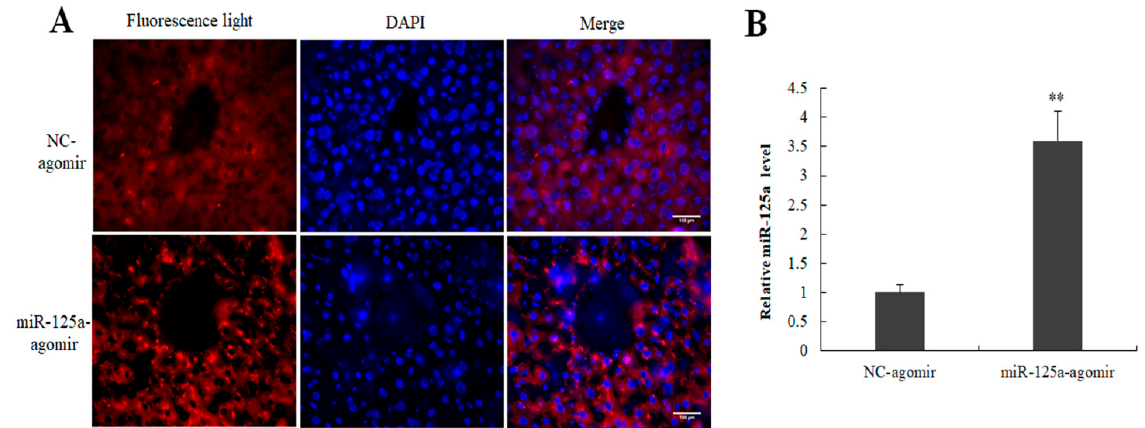
Figure 7. Efficiency detection of miR-125a agomir in mouse liver. ( A ) Cy5-labeled cells were found in miR-125a agomir and its control NC groups by fluorescence microscope. ( B ) miR-125a level was examined through qRT-PCR analysis following injection of miR-125a agomir compared with controls. Data are shown as mean ± SEM. Nuclei were stained with DAPI (blue). Scale bar, 100 µ m, ** p < 0.01.